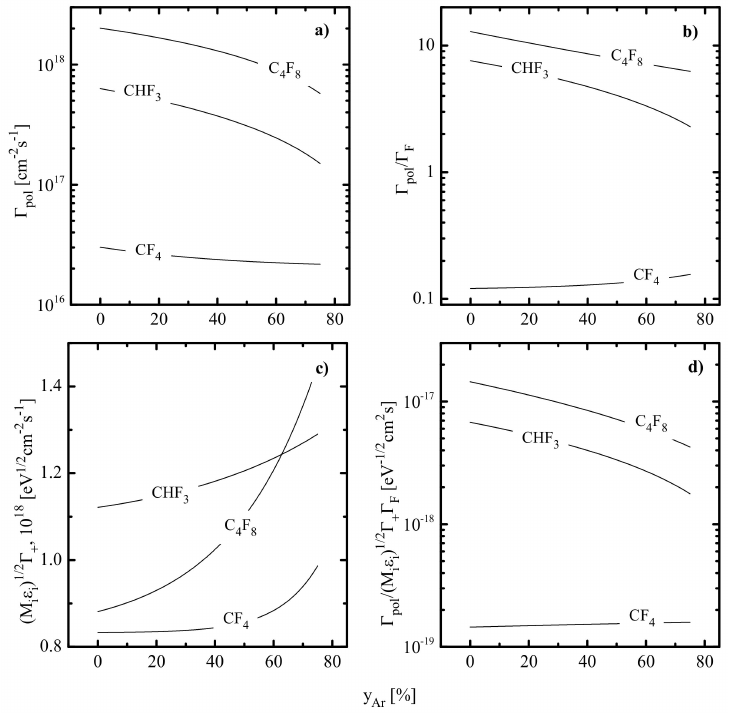
Figure 3. Fluxes and flux-to-flux ratios characterizing etching and polymerization kinetics in CF 4 + Ar, CHF 3 + Ar and C 4 F 8 + Ar plasmas at p = 6 mTorr, W = 700 W and W dc = 200 W: ( a ) total flux of polymerizing radicals; ( b ) Γ pol / Γ F ratio characterizing polymer deposition rate; ( c ) parameter √ M i ε i Γ + characterizing polymer etching rate and ( d ) parameter Γ pol / the change in polymer film thickness due to the physical etching